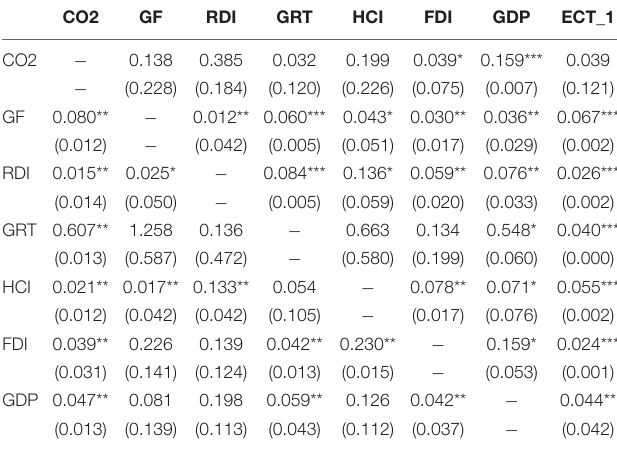
TABLE 7 | Casualty